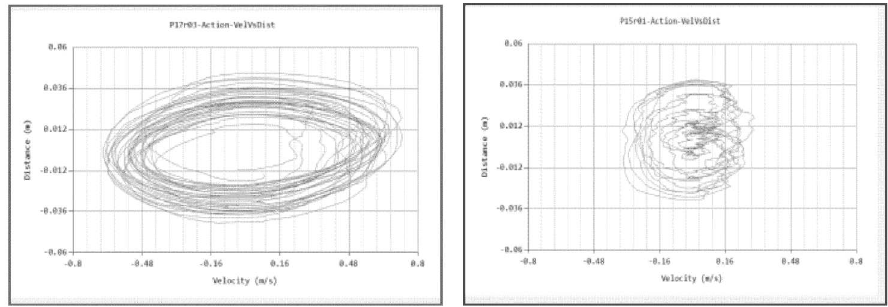
Figure 6. Velocity profile of participant 17 (3rd year, “good”) and participant 15 (1st year,